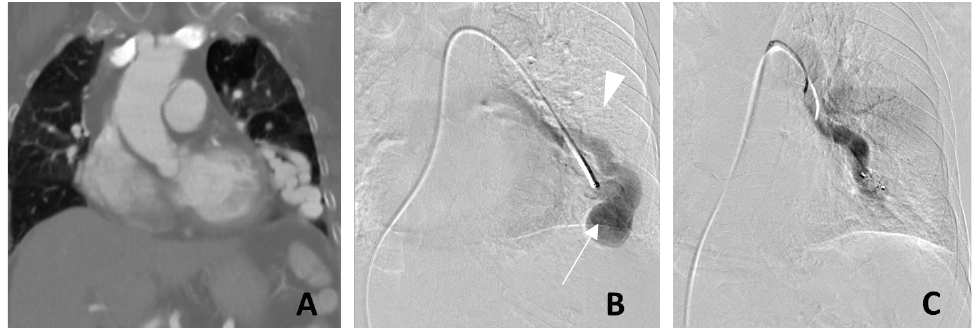
Figure 2. Left lower lobe pulmonary arteriovenous malformation (PAVM) treated with a single Amplatzer™ vascular plug. Coronal contrast-enhanced computed tomography ( A ) demonstrates a large arteriovenous malformation in the left lower lobe with associated cardiomegaly. Digital subtraction angiogram ( B ) demonstrated a high flow PAVM with a large draining vein. ( C ) Complete angiographic cessation of flow following successful embolization with a Type II Amplatzer ™ Vascular Plug. The nidus (arrow) and the draining vein (arrowhead) are no longer opacified on the post-embolization digital subtraction angiogram.